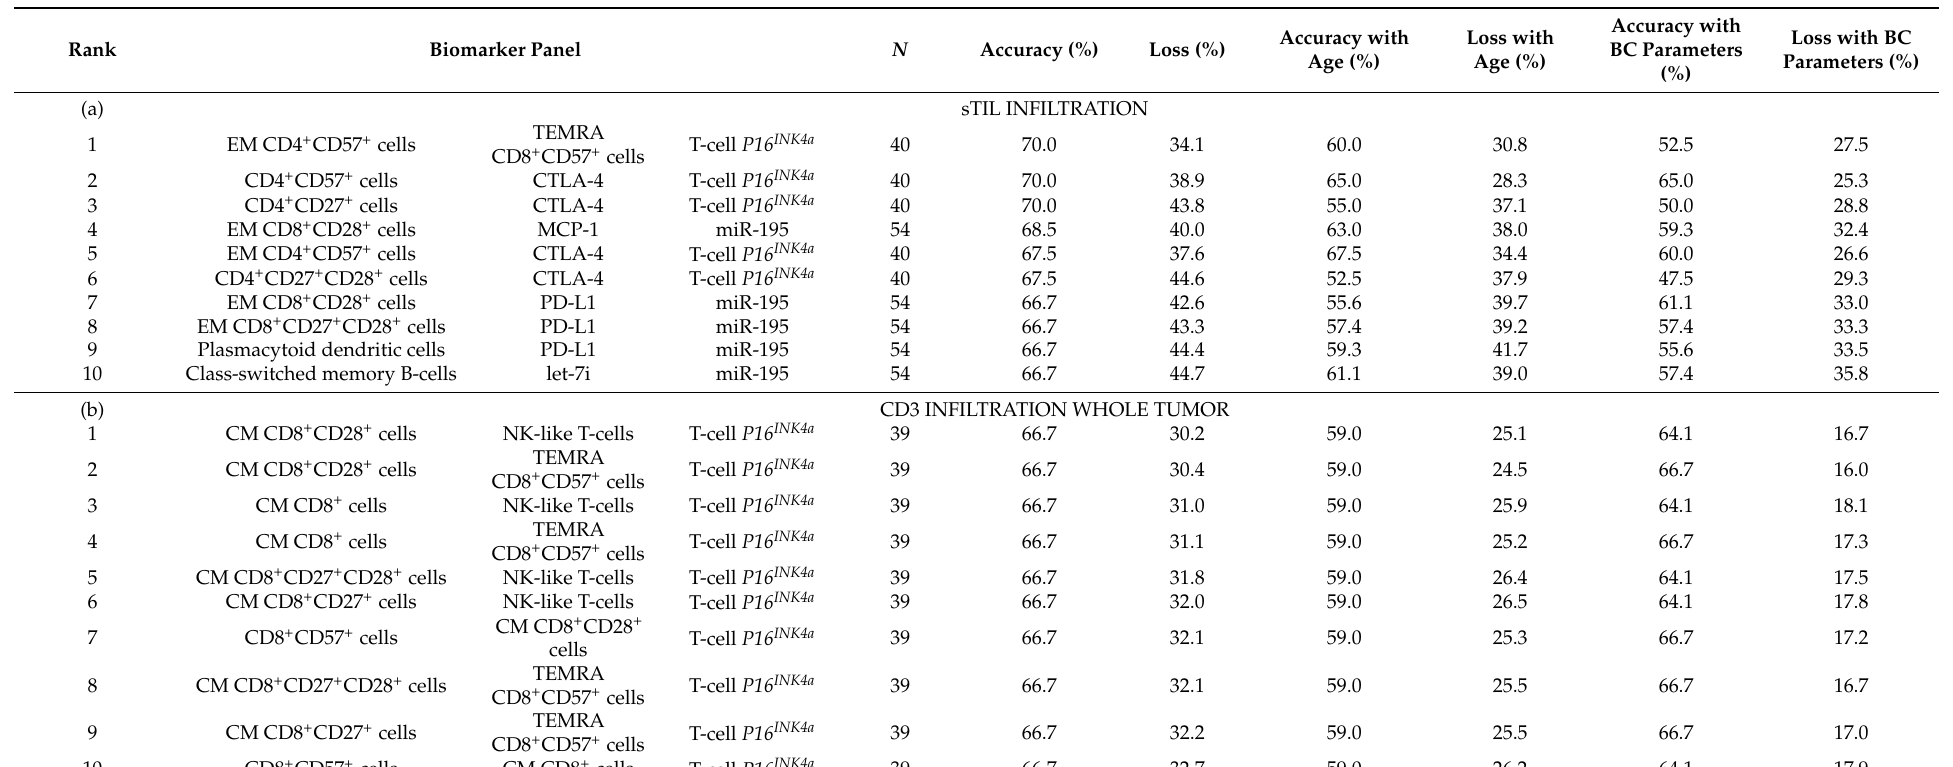
Table 3. Based on the performance of the biomarker panels i.e., highest accuracy and lowest loss, the biomarker panels were assigned a rank. The 10 highest ranked biomarker panels correlating with the tumor immune infiltrate for all patients are shown: (a) sTILs infiltration, (b) CD3 infiltration in the whole tumor, (c) CD3 infiltration at the invasive front, (d) CD8 infiltration in the whole tumor, and (e) CD8 infiltration at the invasive front. The number of patients ( N ) for whom a specific panel could be assessed, the panels’ accuracies and losses are reported as well as the accuracy and loss of the panel when age or BC parameters (tumor size, tumor grade and lymph node involvement) are added to